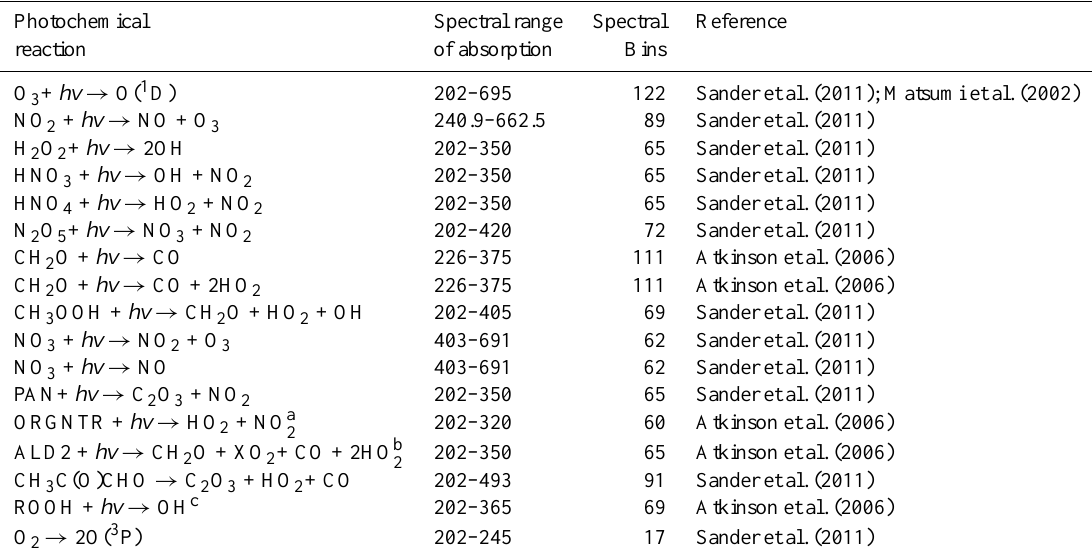
Table 1. Details of the photodissociation reactions calculated in TM5 with the modified band approach (MBA). The number of spectral bins needed for deriving each respective J -value as defined by the availability of σ - and φ -values are given, where the size of the original spectral grid of Br¨uhl and Crutzen (1988) is 142 individual spectral